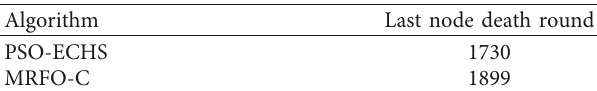
Table 6: Last node death round for 1000-by-1000 area and 1000 nodes.